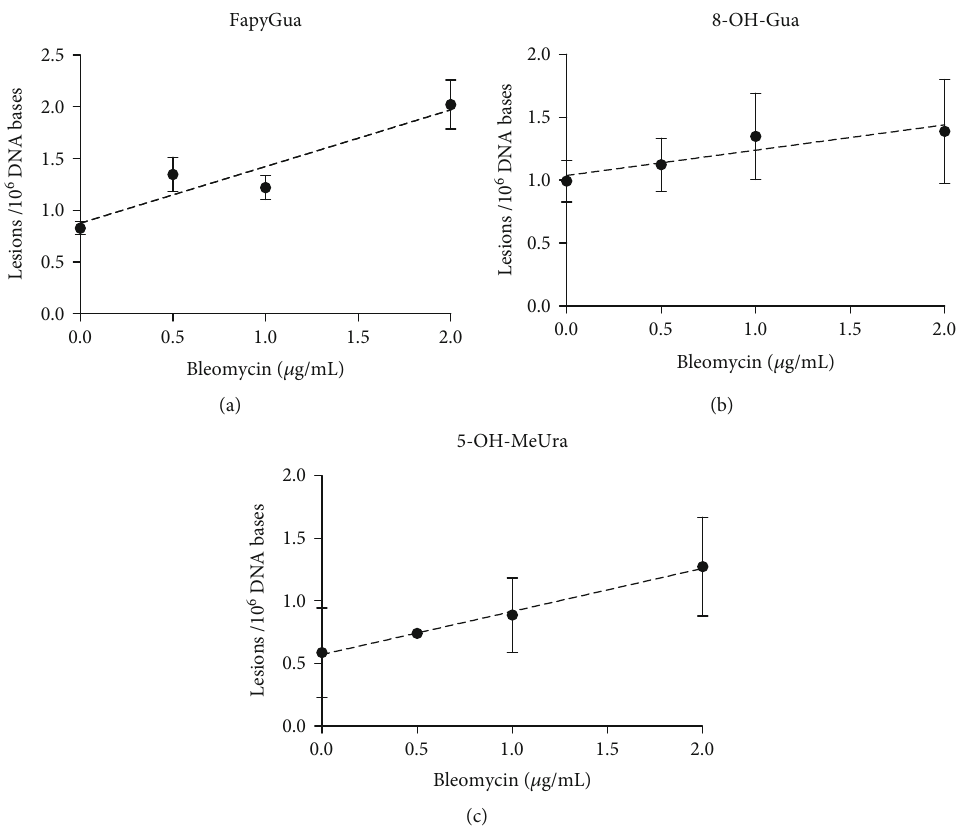
Figure 4: GC-MS/MS — comparison of the induction of (a) FapyGua, (b) 8-OH-Gua, and (c) 5-OH-MeUra by bleomycin. The data are plotted as the mean and standard deviation of 4 separate replicates, performed in parallel, as described in Materials and Methods. Statistical analysis is given in Table